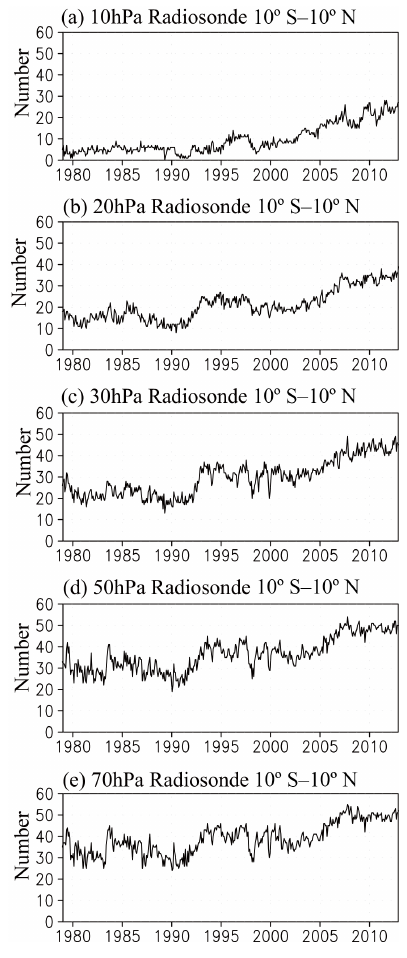
Figure 15. Time variation in number of radiosonde observations at 10 ◦ S–10 ◦ N at (a) 10, (b) 20, (c) 30, (d) 50, and (e) 70hPa from 1979 to